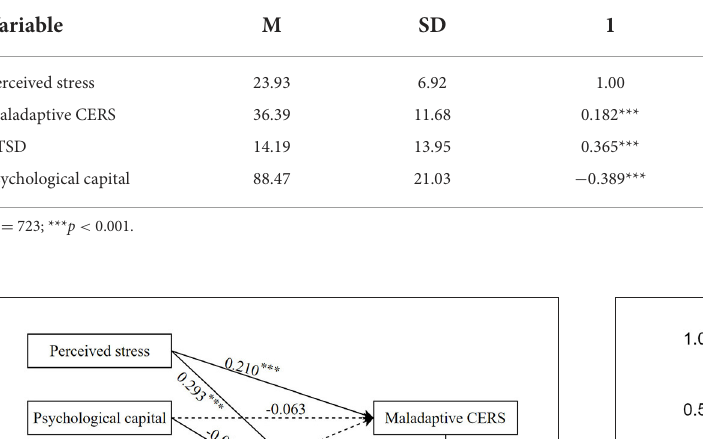
TABLE 2 Descriptive statistics and correlations for all variables.